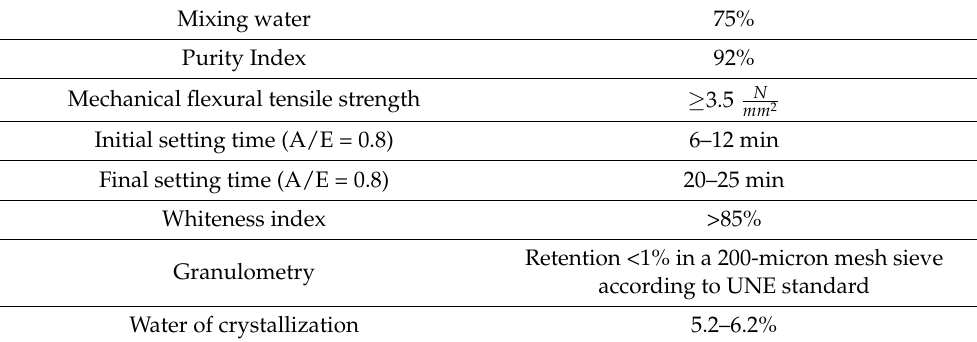
Table 1. Technical characteristics of the plaster used.